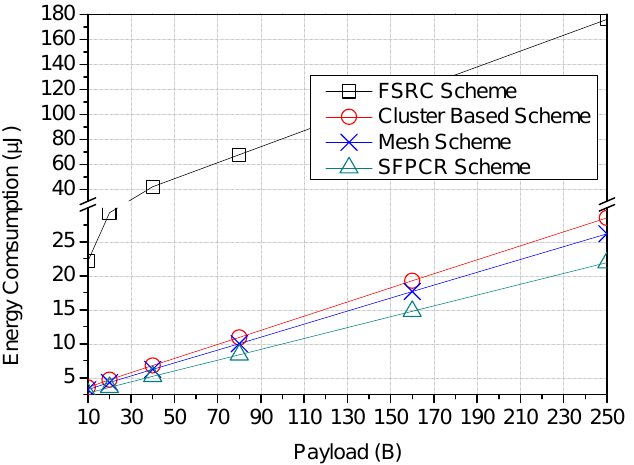
Figure 9. Energy consumption as a function of payload size (B) with a comparison between the proposed SFPCR scheme and other protocols.